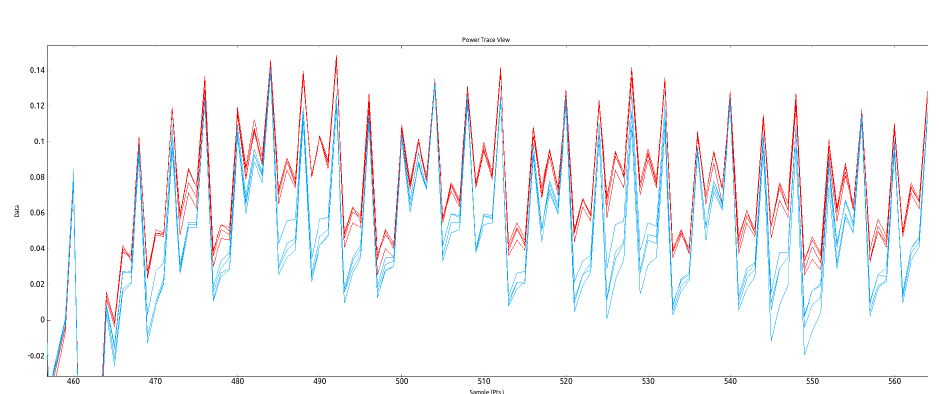
Figure 4: Power traces of the device around 130 cycles after the call to compress : blue (resp. red) traces correspond to e R of order 2 (resp. at